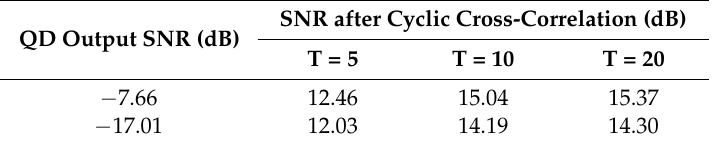
Table 1. The changes of signal-to-noise ratio (SNR) with different data lengths.